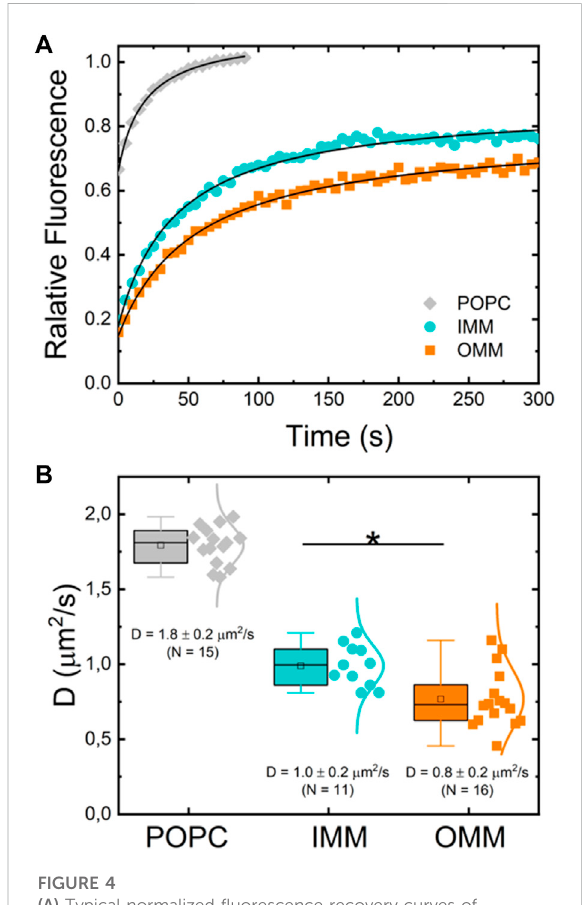
FIGURE 4 (A) Typical normalized fl uorescence recovery curves of supportedlipidbilayersofPOPC(graydiamonds),IMMlipidextract (cyan circles) and OMM lipid extract (orange squares) supplemented with 0.1% mol of fl uorescent lipid RhPE. (B) Diffusion coef fi cient of RhPE in POPC ( N = 15), OMM ( N = 16), and IMM ( N = 11) lipid bilayers obtained from FRAP curves.